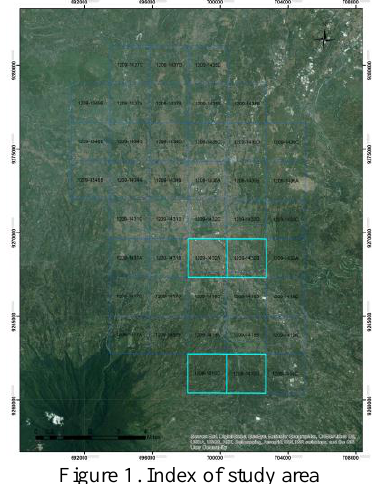
Figure 1. Index of study